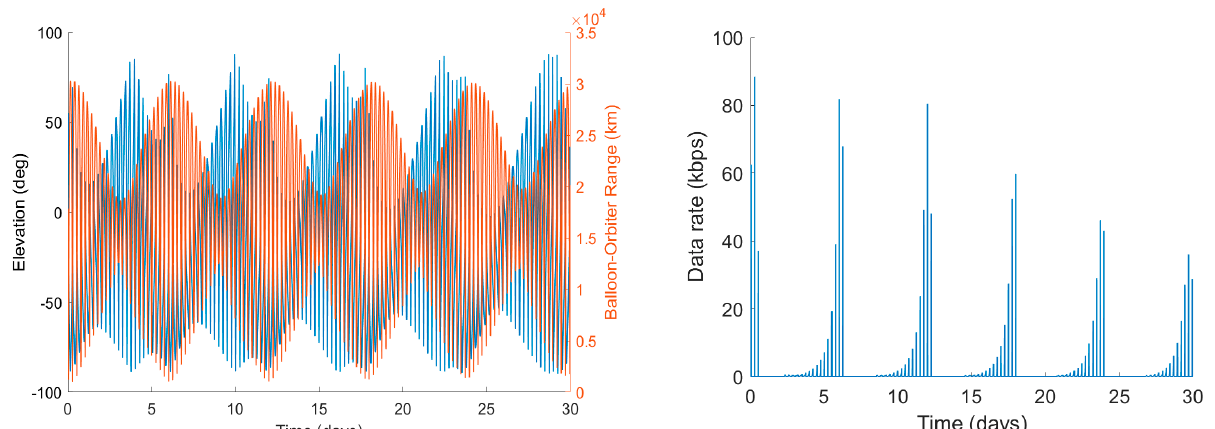
Figure 11. Communication link between balloon and orbiter. Left: Elevation and range of orbiter with respect to the balloon. Right: Data rate of downlink over 30 Earth days. The orbiter has about 16 contacts with the balloon over one circumnavigation, each of roughly 8 to 10 min duration. We assume that the balloon circumnavigates Venus in six days and drifts 10 degrees longitudinally over 30 days. The drift is calculated based on Venus GRAM wind models.